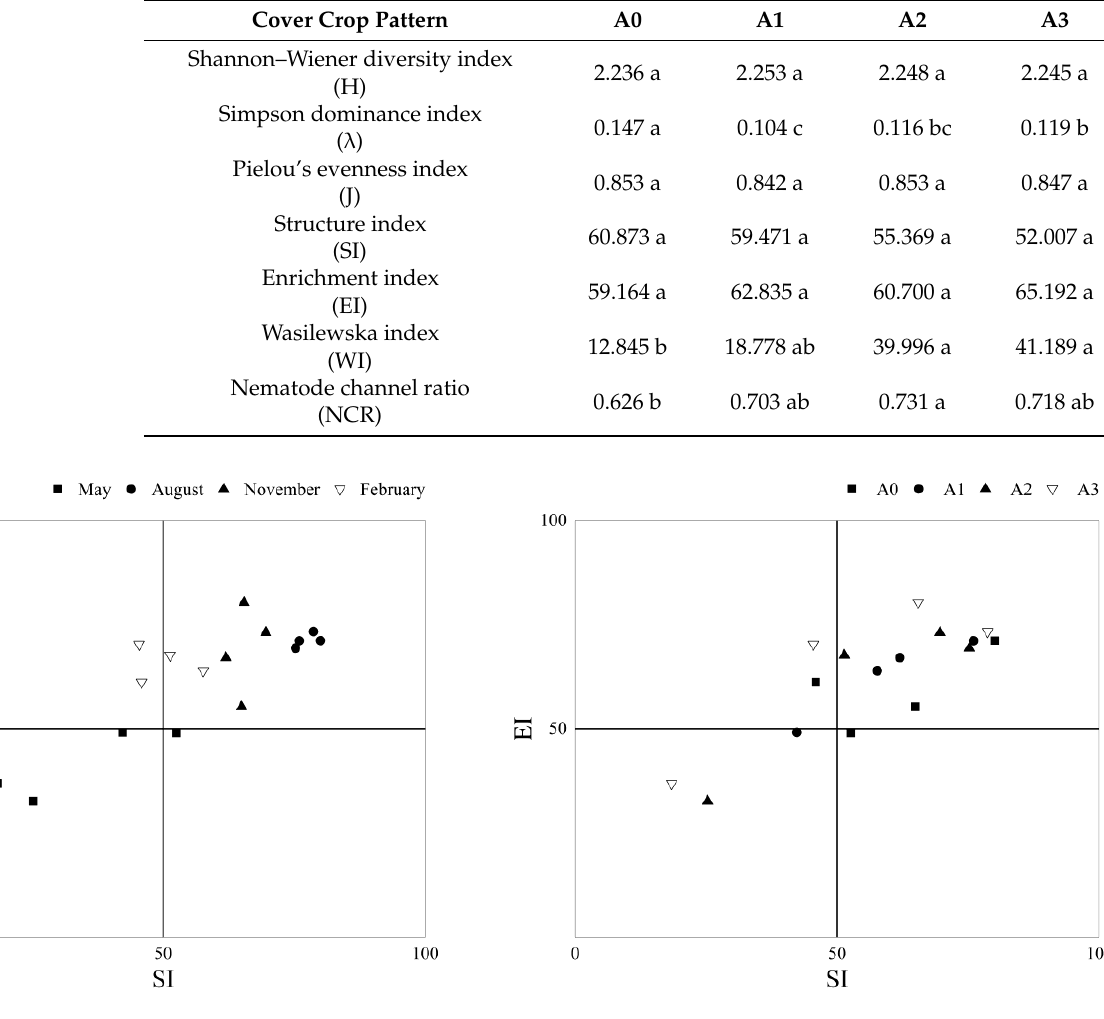
Figure 4. Variation of the total phospholipid fatty acids (PLFAs) in microorganisms. Different capi- tal letters indicate the significant differences between different cover crop patterns in the same month, and different lowercase letters indicate the significant differences between different months in the same cover crop patterns ( p < 0.05). As shown in Figure 5, the interaction of the monthly variation and cover crop pat- terns showed no significant effect on the soil microbial community. The percentage of soil fungi and common bacteria in different months under various cover crop patterns was shown in Figure S1. Our results found that the number of soil microorganisms was mainly affected by seasonal changes, and cover crop diversity only had a significant impact on